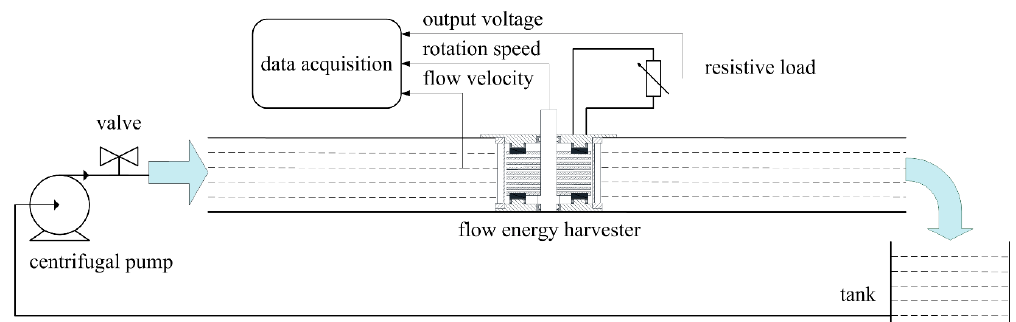
Figure 8. Schematic of experimental setup for flow energy harvester.